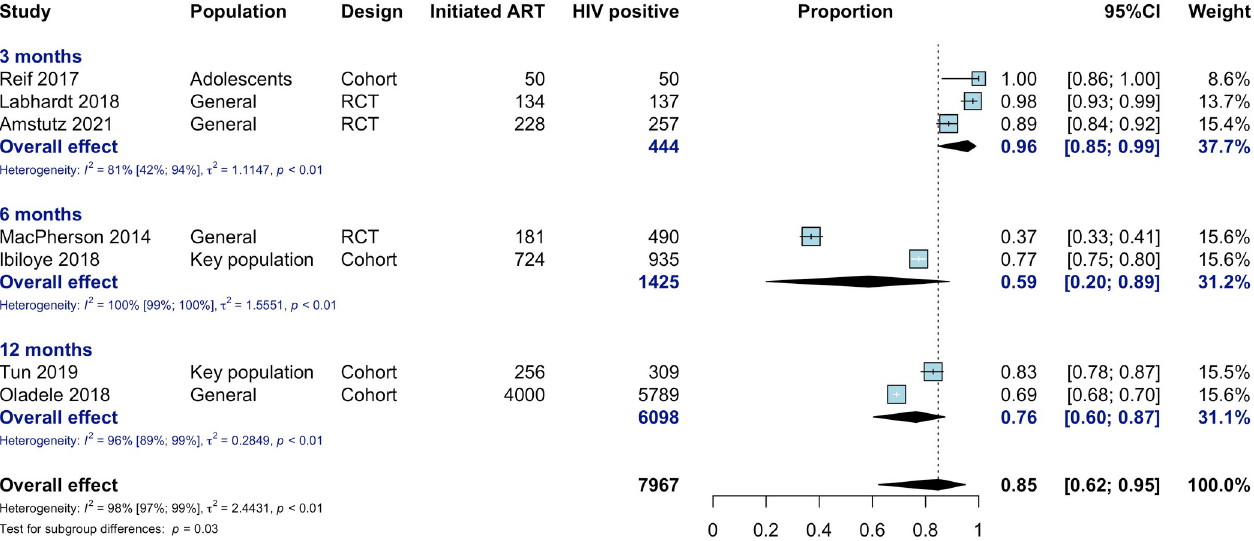
Fig 2. ART uptake in community ART initiation study arms, among HIV-positive and by outcome measurement time point. Tun 2019 was conducted in female sex workers; Ibiloye 2018 included female sex workers, men who have sex with men, people who inject drugs, and partners of individuals in these key